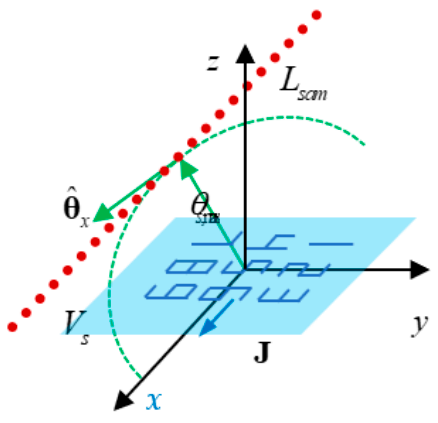
Figure 11. Sample on a linear grid L sam right above the